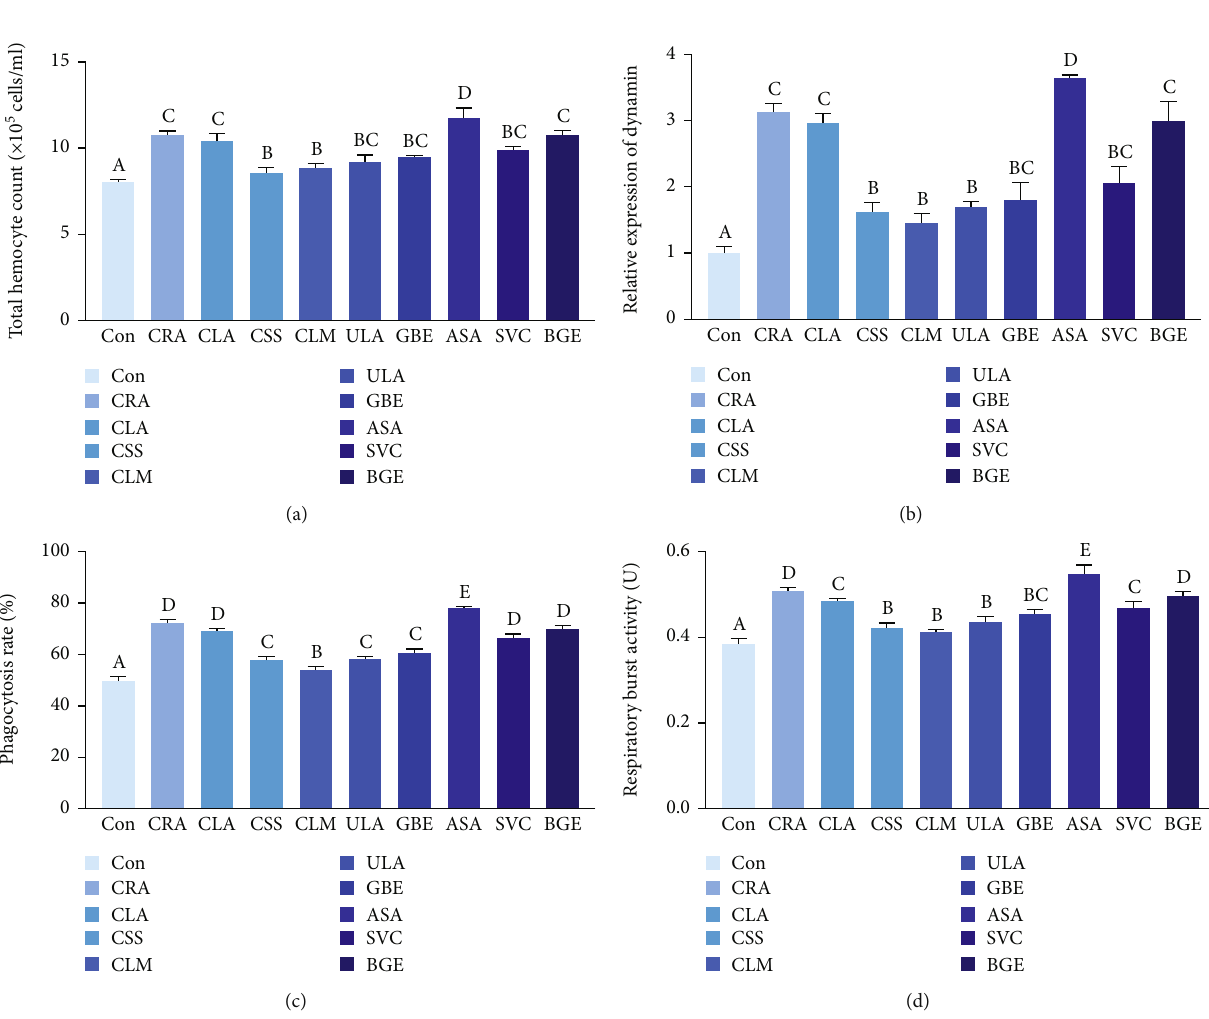
Figure 1: E ff ects of macroalgae diet on the cellular immunity of L. vannamei . Total hemocyte count (a), relative expression of dynamin (b), phagocytic rate (c), and respiratory burst activity (d) of L. vannamei in di ff erent groups. All data are expressed as mean ± SE ( n = 3 ). The mean column of di ff erent superscript letters (A – E) was signi fi cantly di ff erent ( P < 0 : 05